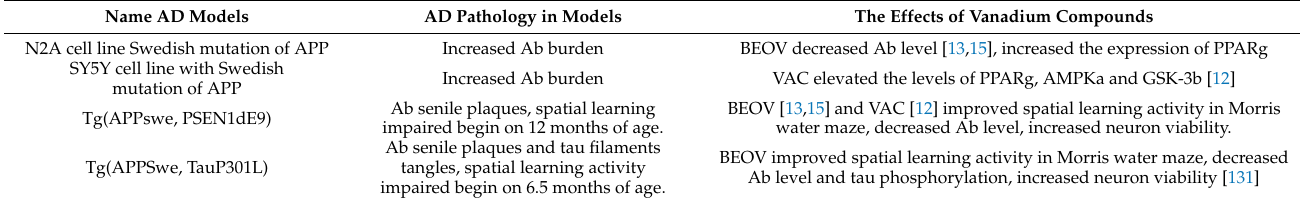
Table 1. The effects of vanadium compound in different AD models.